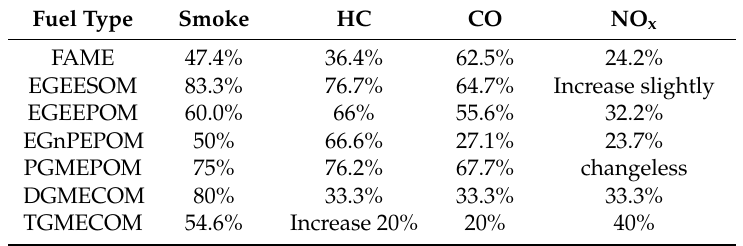
Table 4. Maximal reduction rate of emissions when using pure biodiesels